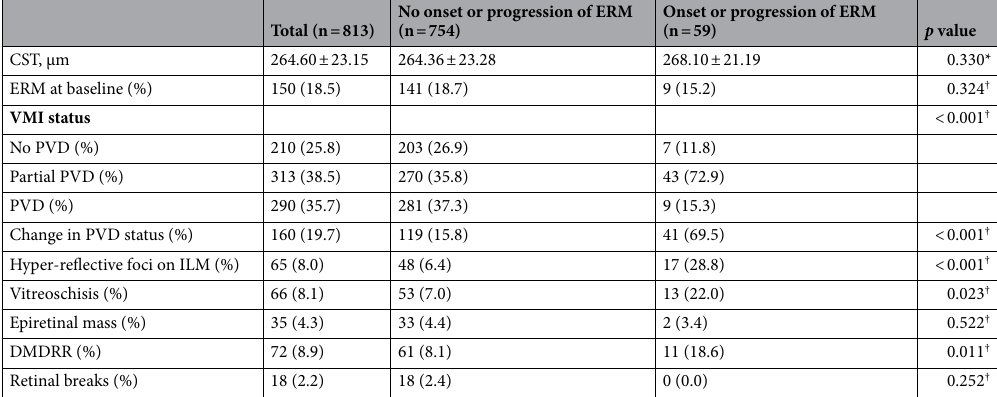
Table 2. Ocular parameters from SD-OCT and UWF-FP in the present study. CST central subfoveal thickness, DMDRR discrete margin of different retinal reflectivity, ERM epiretinal membrane, ILM internal limiting membrane, PSD pachychoroid spectrum disease, PVD posterior vitreous detachment, VMI vitreomacular interface. Data are mean ± standard deviation unless otherwise indicated. Student’s t-test* or Chi-square test † was used.